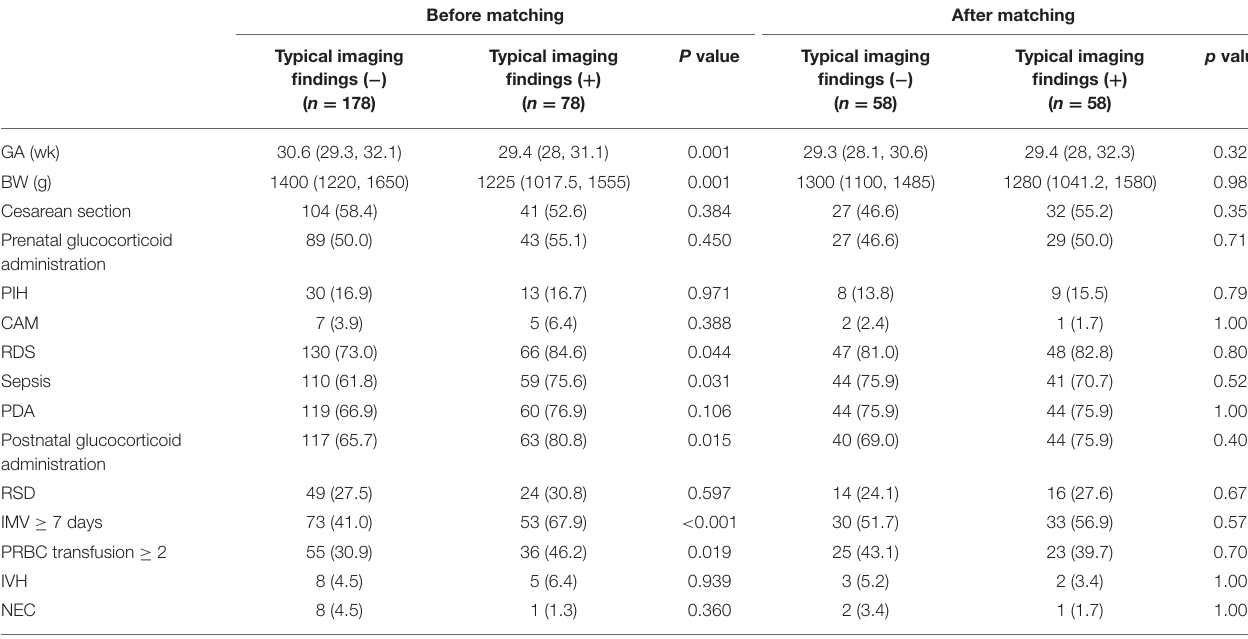
TABLE 1 | Characteristics of the preterm infants included in the propensity score analysis.